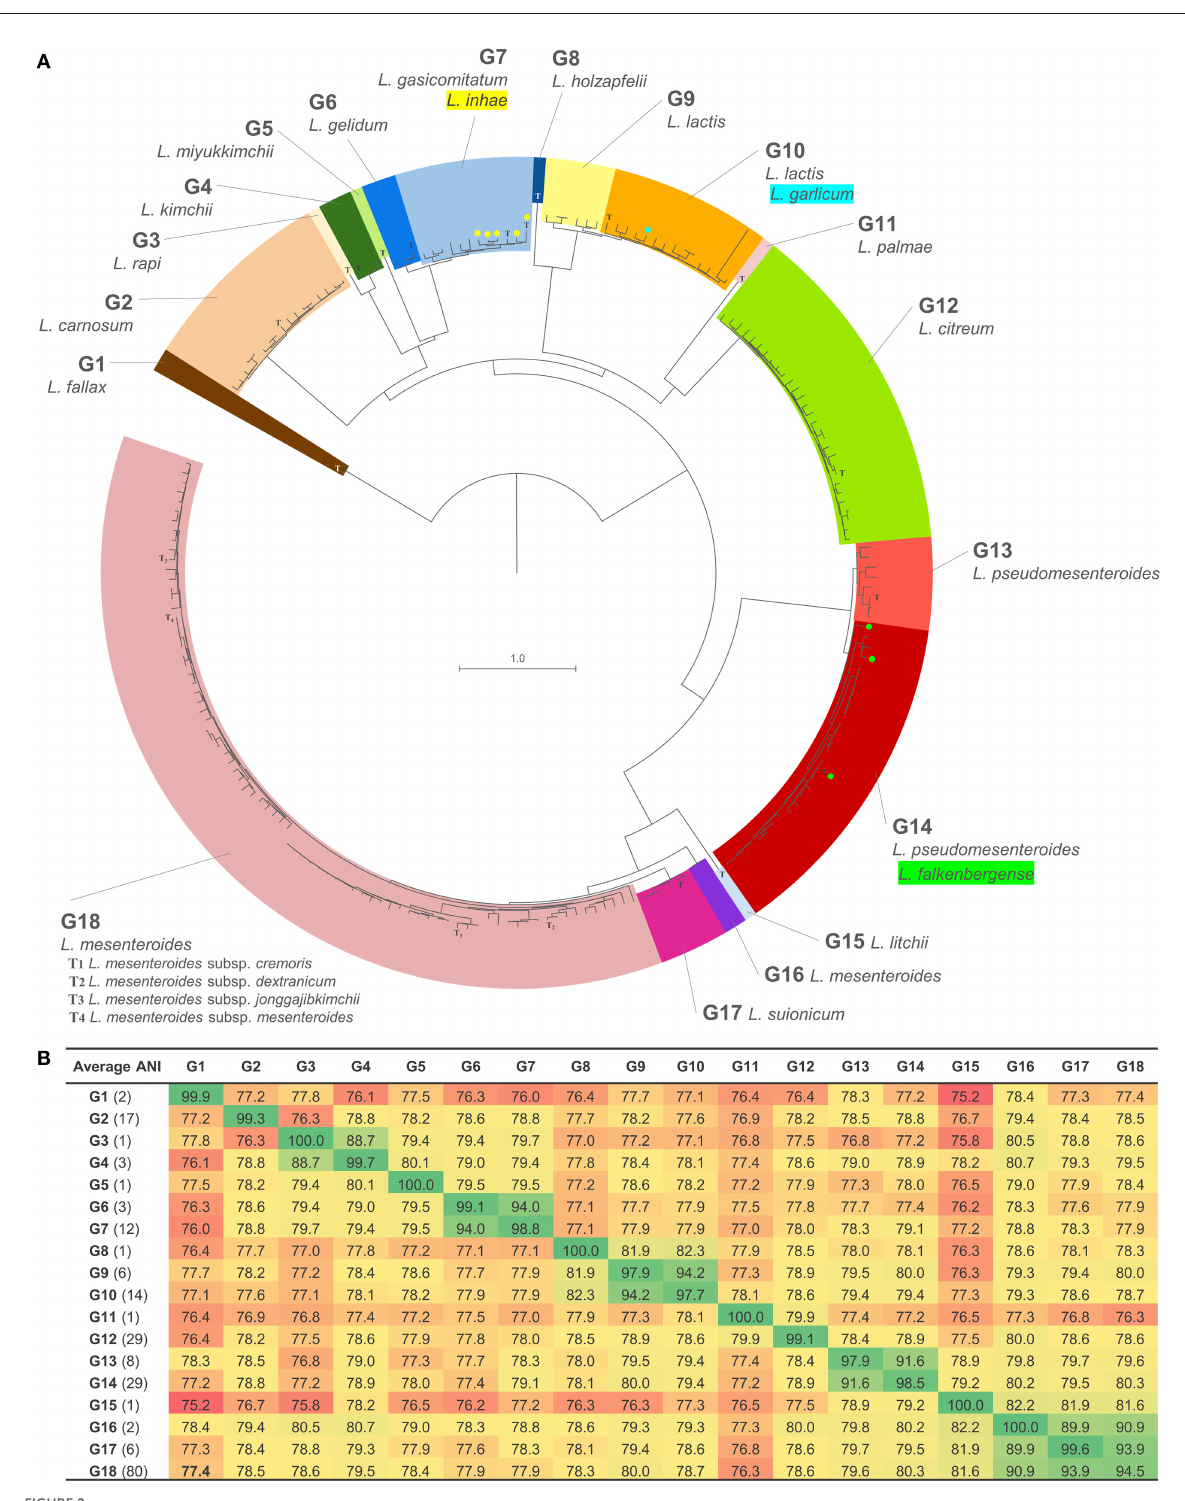
FIGURE2 Phylogenomic analysis of Leuconostoc species: (A) Minimum evolution tree of ANI, reporting the 18 proposed clades with values > 95%; T, type strain; strains currently ascribed to the species of L. falkenbergense , L. garlicum , and L. inhae are indicated in green, cyan, and yellow, respectively. (B) Heatmap of the mean ANI values between the strains of the